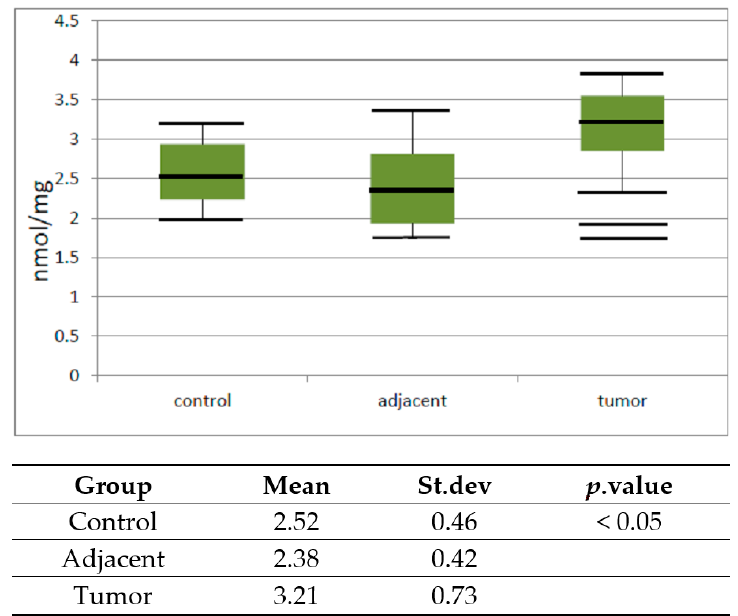
Figure 4. Vertical boxplot for catalase activity in control healthy tissue, tissue adjacent to tumor and tumor prostate tissue. The median is identified by a line inside the box, the boundaries of the box are interquartile range (IQR). Bars = entire range. Values more than 75th percentile are labelled as extreme and denoted as the horizontal lines beyond the